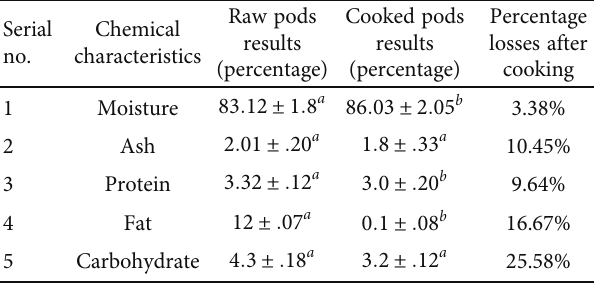
Table 1: E ff ect of thermal processing on the physiochemical properties of Moringa oleifera